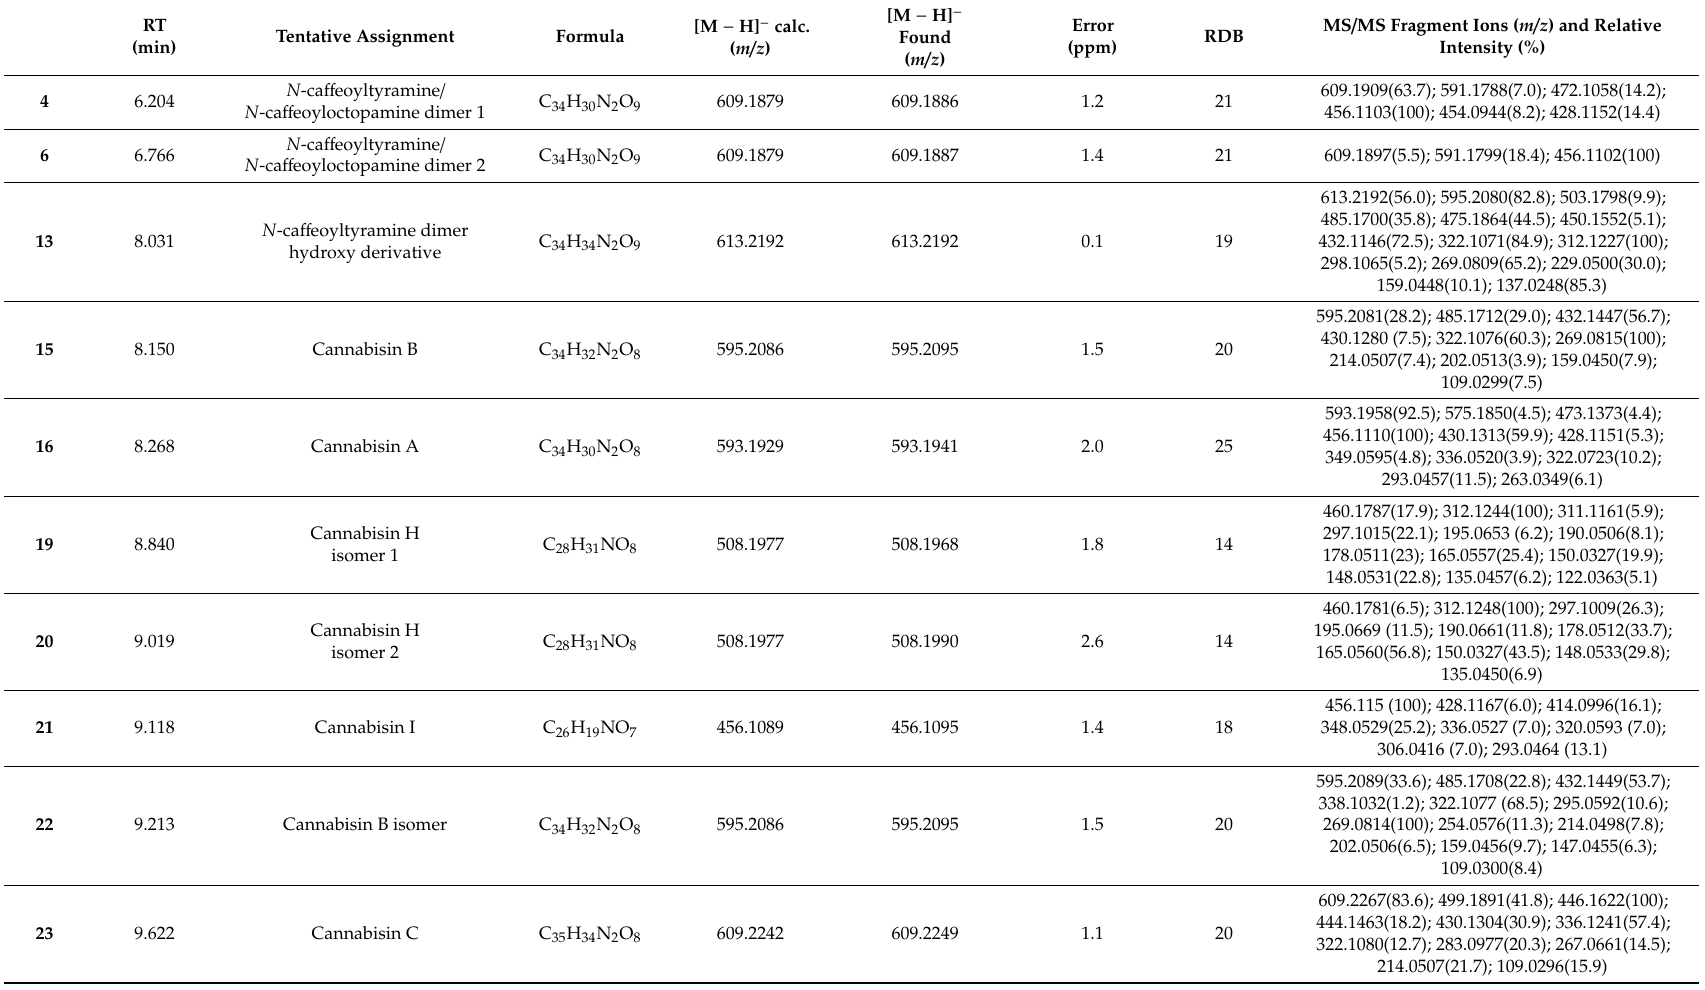
Table 2. TOF-MS and TOF-MS / MS of tentatively identified lignanamides in the investigated hempseed fraction. RT = Retention Time; RDB = Ring Double Bond equivalent value. Compounds were numbered based on their RT in the whole LnHS